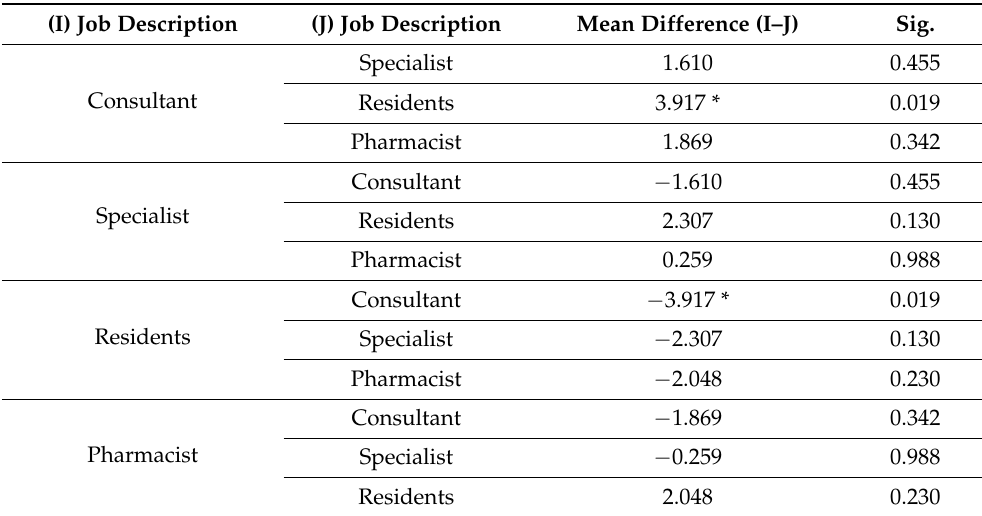
Table 5. Post-hoc analysis of the multiple mean differences in the score of knowledge and practice according to the job description (N = 63)